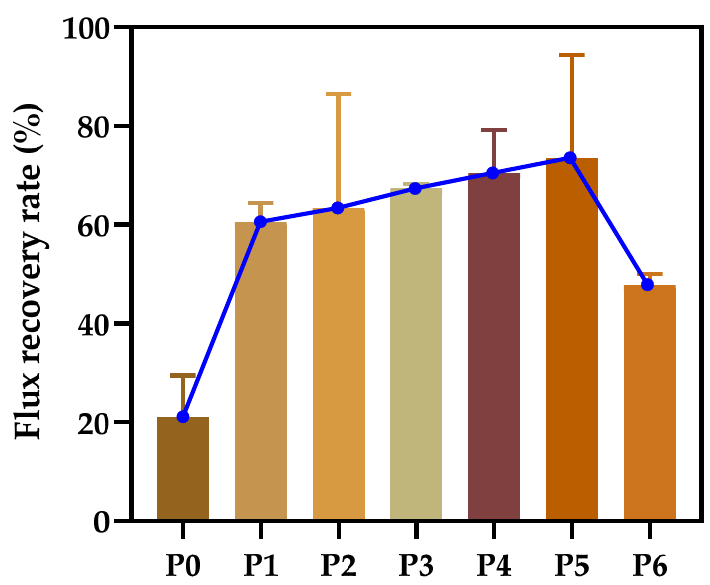
Figure 12. Flux recovery rate of various PA66 membranes.